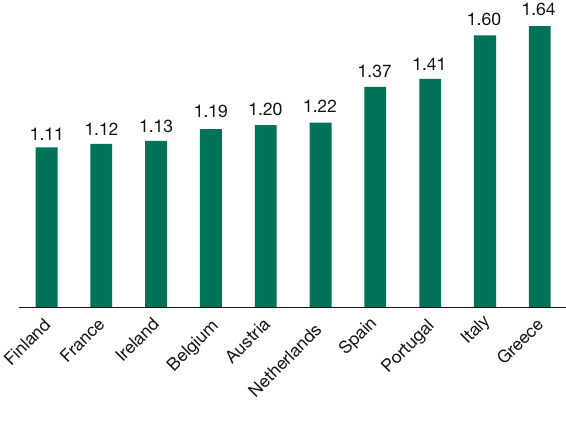
Figure 4 Change in the yield of the 10-year government bond rates per 1% change of the German bond rate, January to June